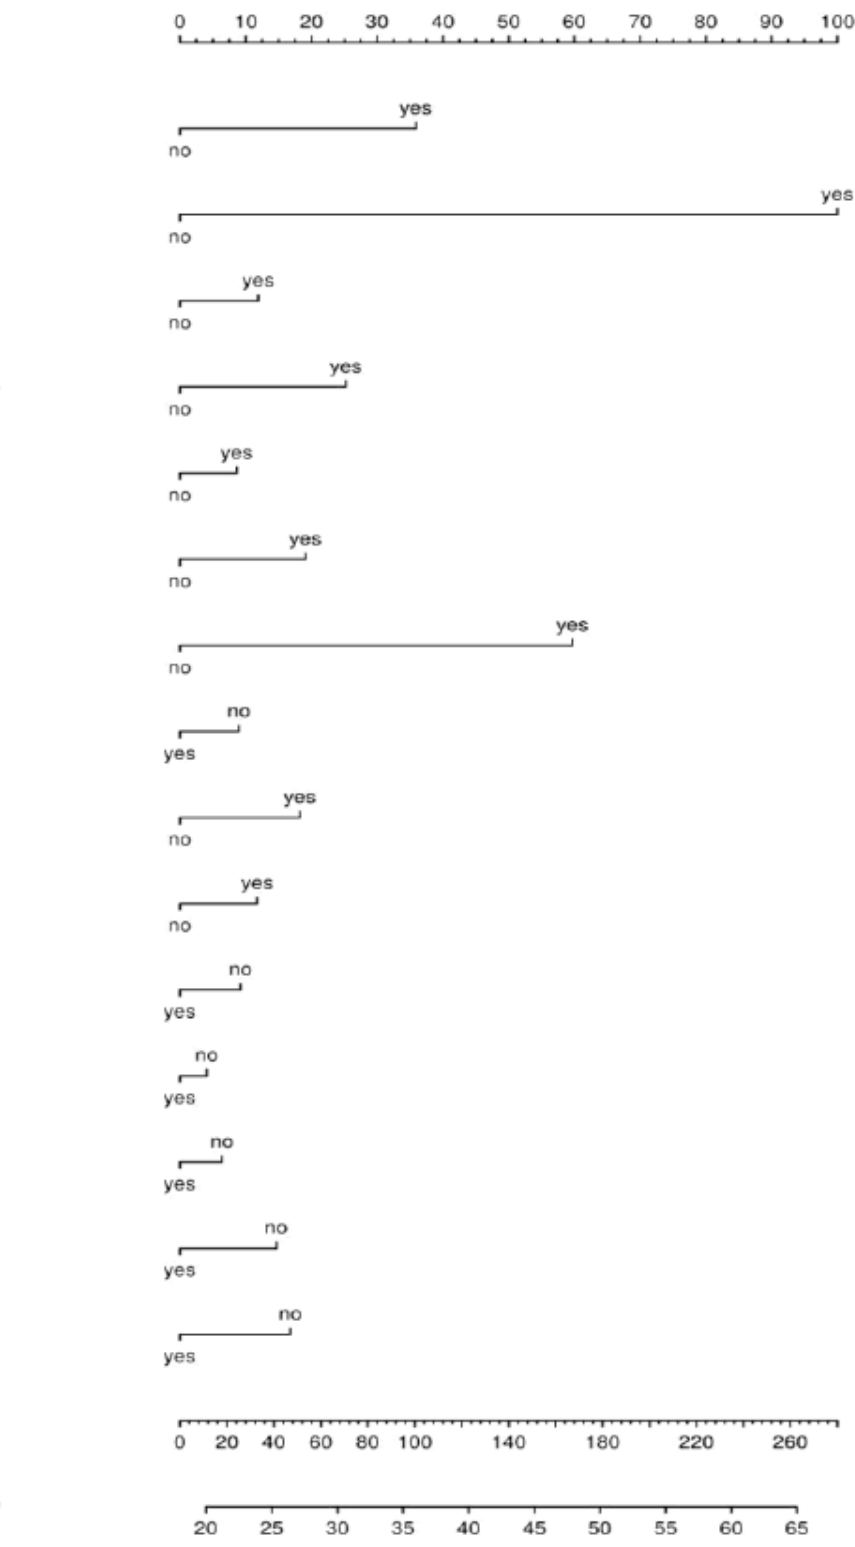
Figure A3. Nomogram total disability score at Figure 3. Nomogram total disability score at T9. Table 4. Rsq-values and relative importance TFI items for the total disability scores.